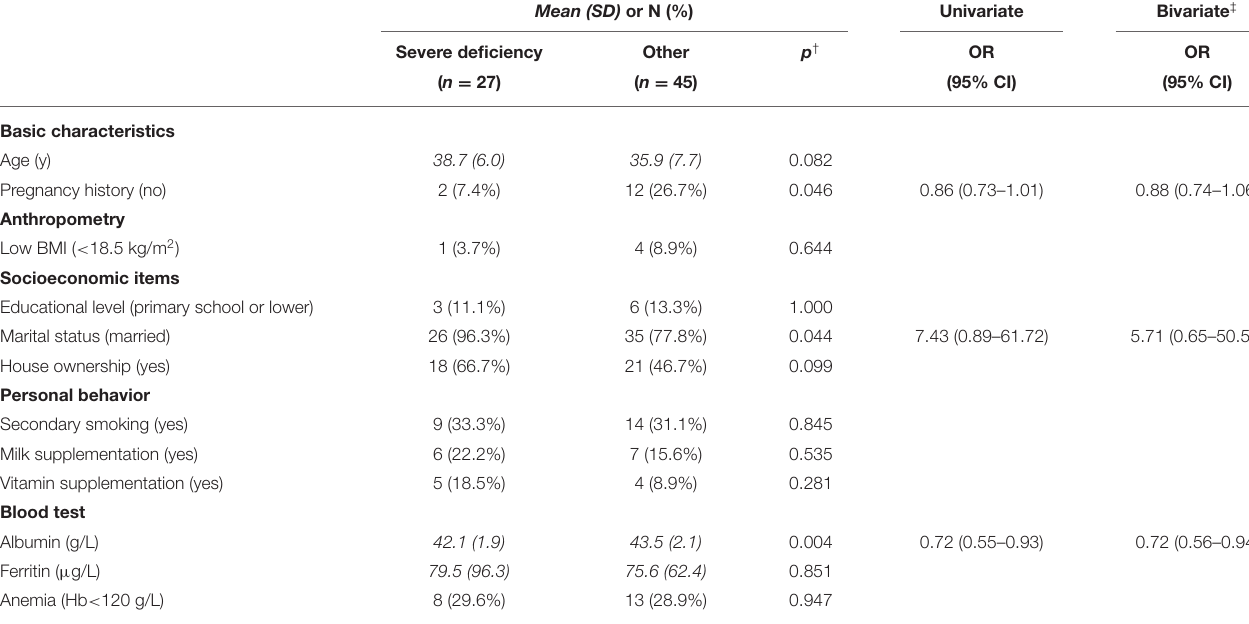
TABLE 2 | Severe zinc deficiency and associated